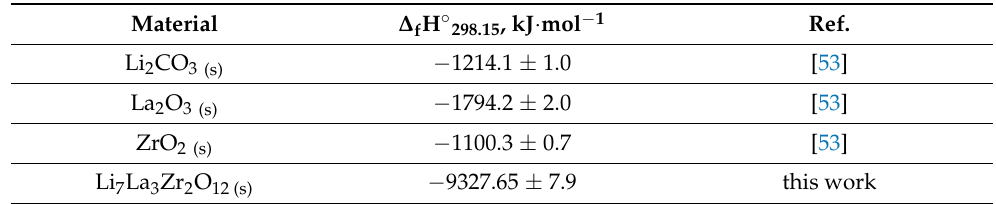
Table 4. Standard enthalpies of formation from elements ( ∆ f H 0 ). Material ∆ f H ◦ 298.15 , kJ · mol − 1 Ref. Li 2 CO 3 (s) − 1214.1 ± 1.0 [53] La 2 O 3 (s) − 1794.2 ± 2.0 [53] ZrO 2 (s) − 1100.3 ± 0.7 [53] Li 7 La 3 Zr 2 O 12 (s) − 9327.65 ± 7.9 this